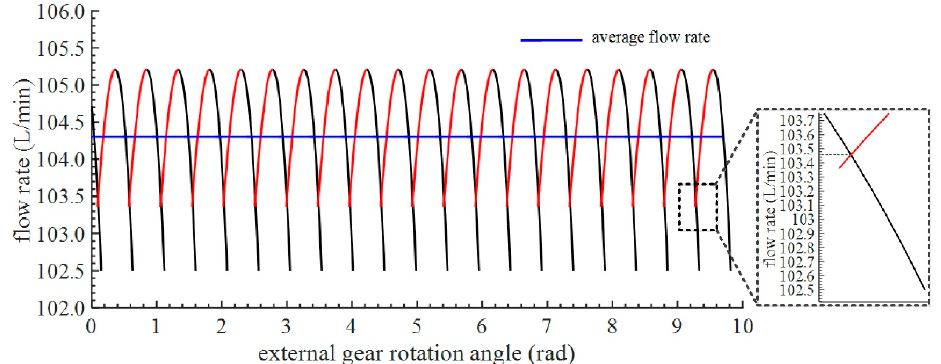
Figure 5. Theoretical flow rate curves corresponding to theoretical coincidence degree.